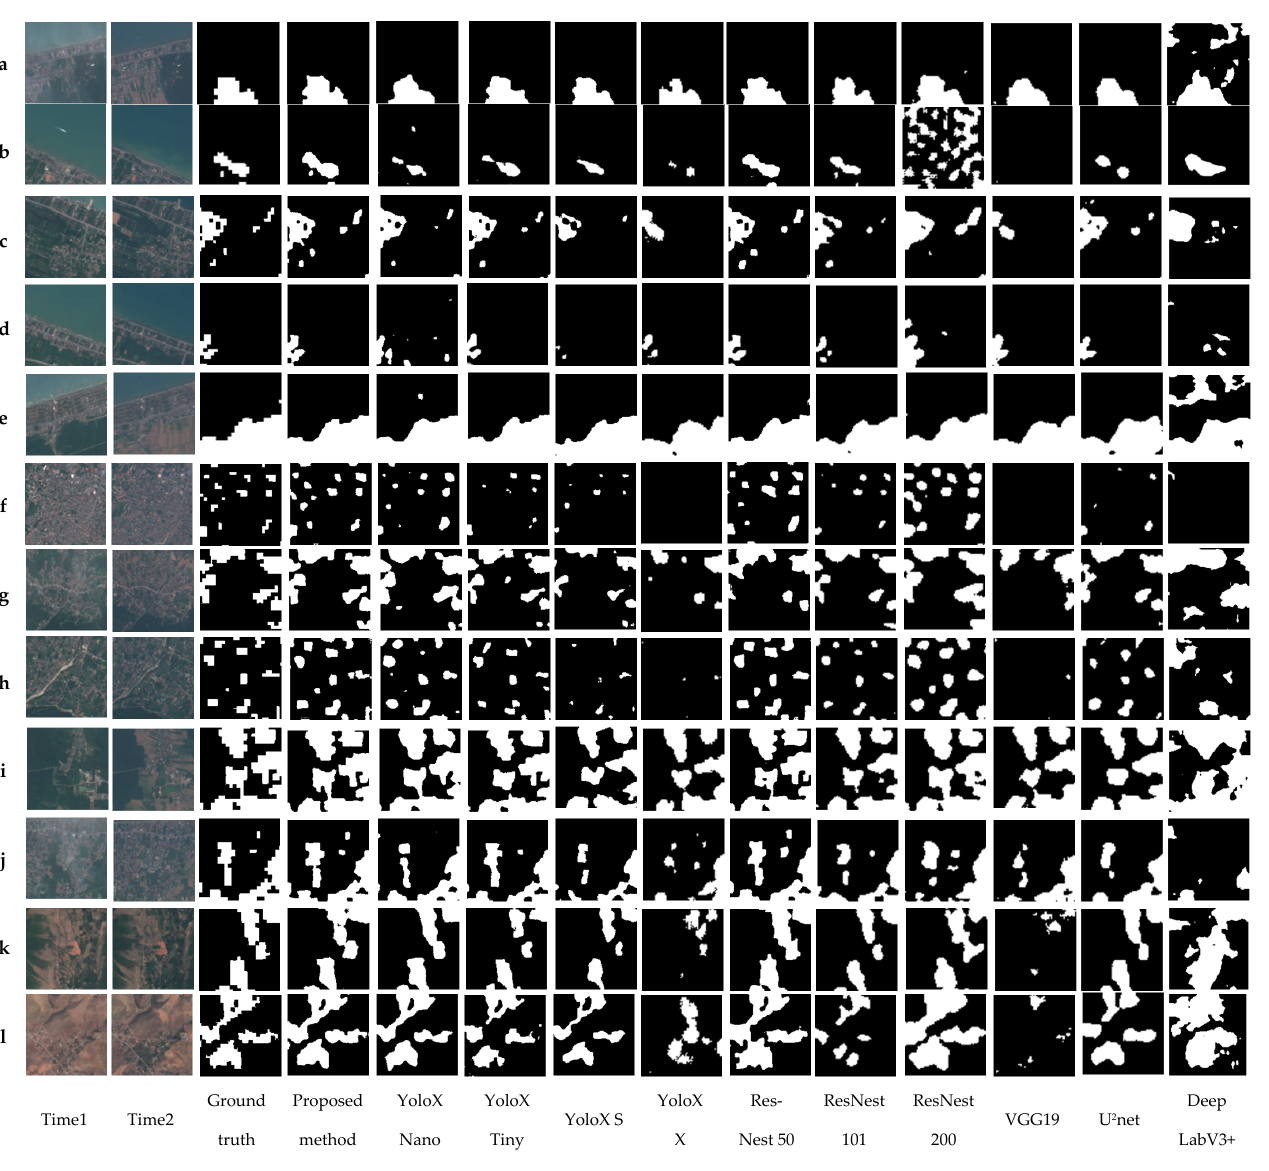
Figure 10. Results of coastal areas ( a – e ), results of areas located near the forest and agricultural land ( f – j ), and results of areas which are located on the foothills ( k , l ).